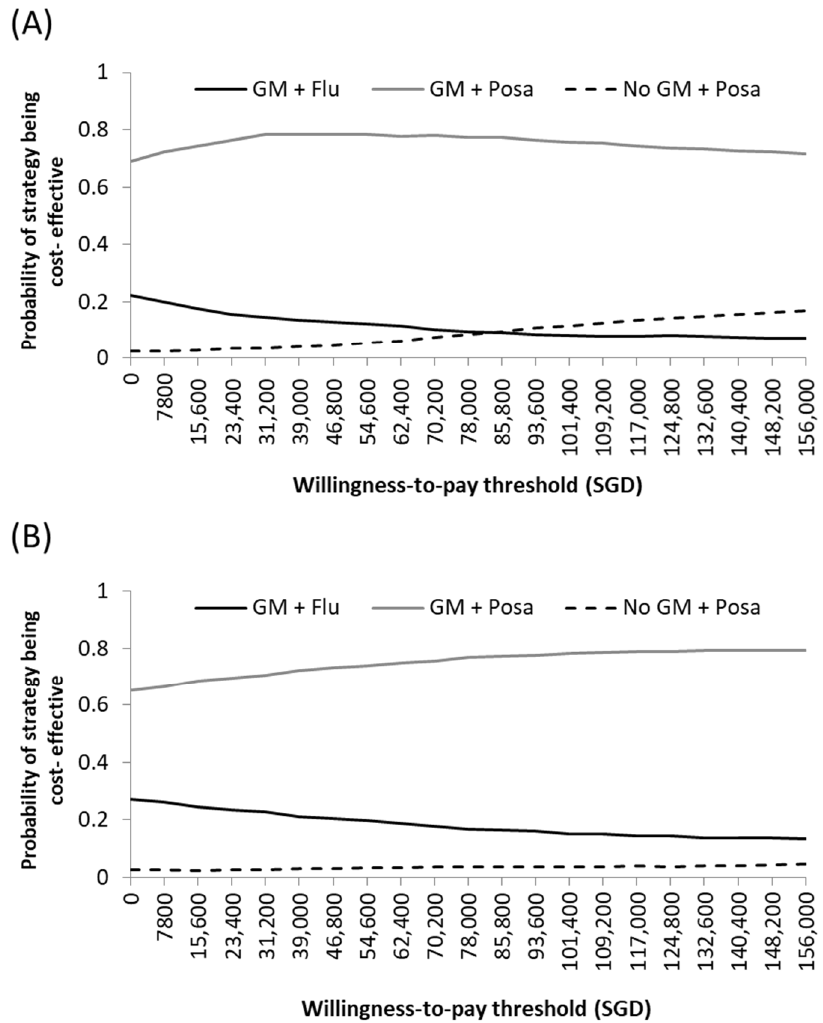
Figure 3. Cost-effectiveness acceptability curve representing probability sensitivity analysis of various prophylaxis-biomarker strategies in ( A ) 40-year-old and ( B ) 60-year-old cohorts. The cost-effectiveness acceptability curve indicated the probability of each strategy being cost-effective over a range of willingness-to-pay (WTP) threshold. The likelihood that the WTP fell within SGD 82,000 per quality-adjusted life-year (QALY) gained (equivalent to one gross domestic product per capita in Singapore, 2020) was 77% when applying routine galactomannan surveillance in conjunction with mould-active prophylaxis across both age ranges. When applying non-mould-active prophylaxis with galactomannan surveillance and mould-active prophylaxis with no galactomannan monitoring, this probability was ( A ) 9% and 10%, respectively, in the 40-year-old cohort, and ( B ) 16% and 4%, respectively, in the 60-year-old cohort. FLU: fluconazole, GM: galactomannan, POSA: posaconazole.